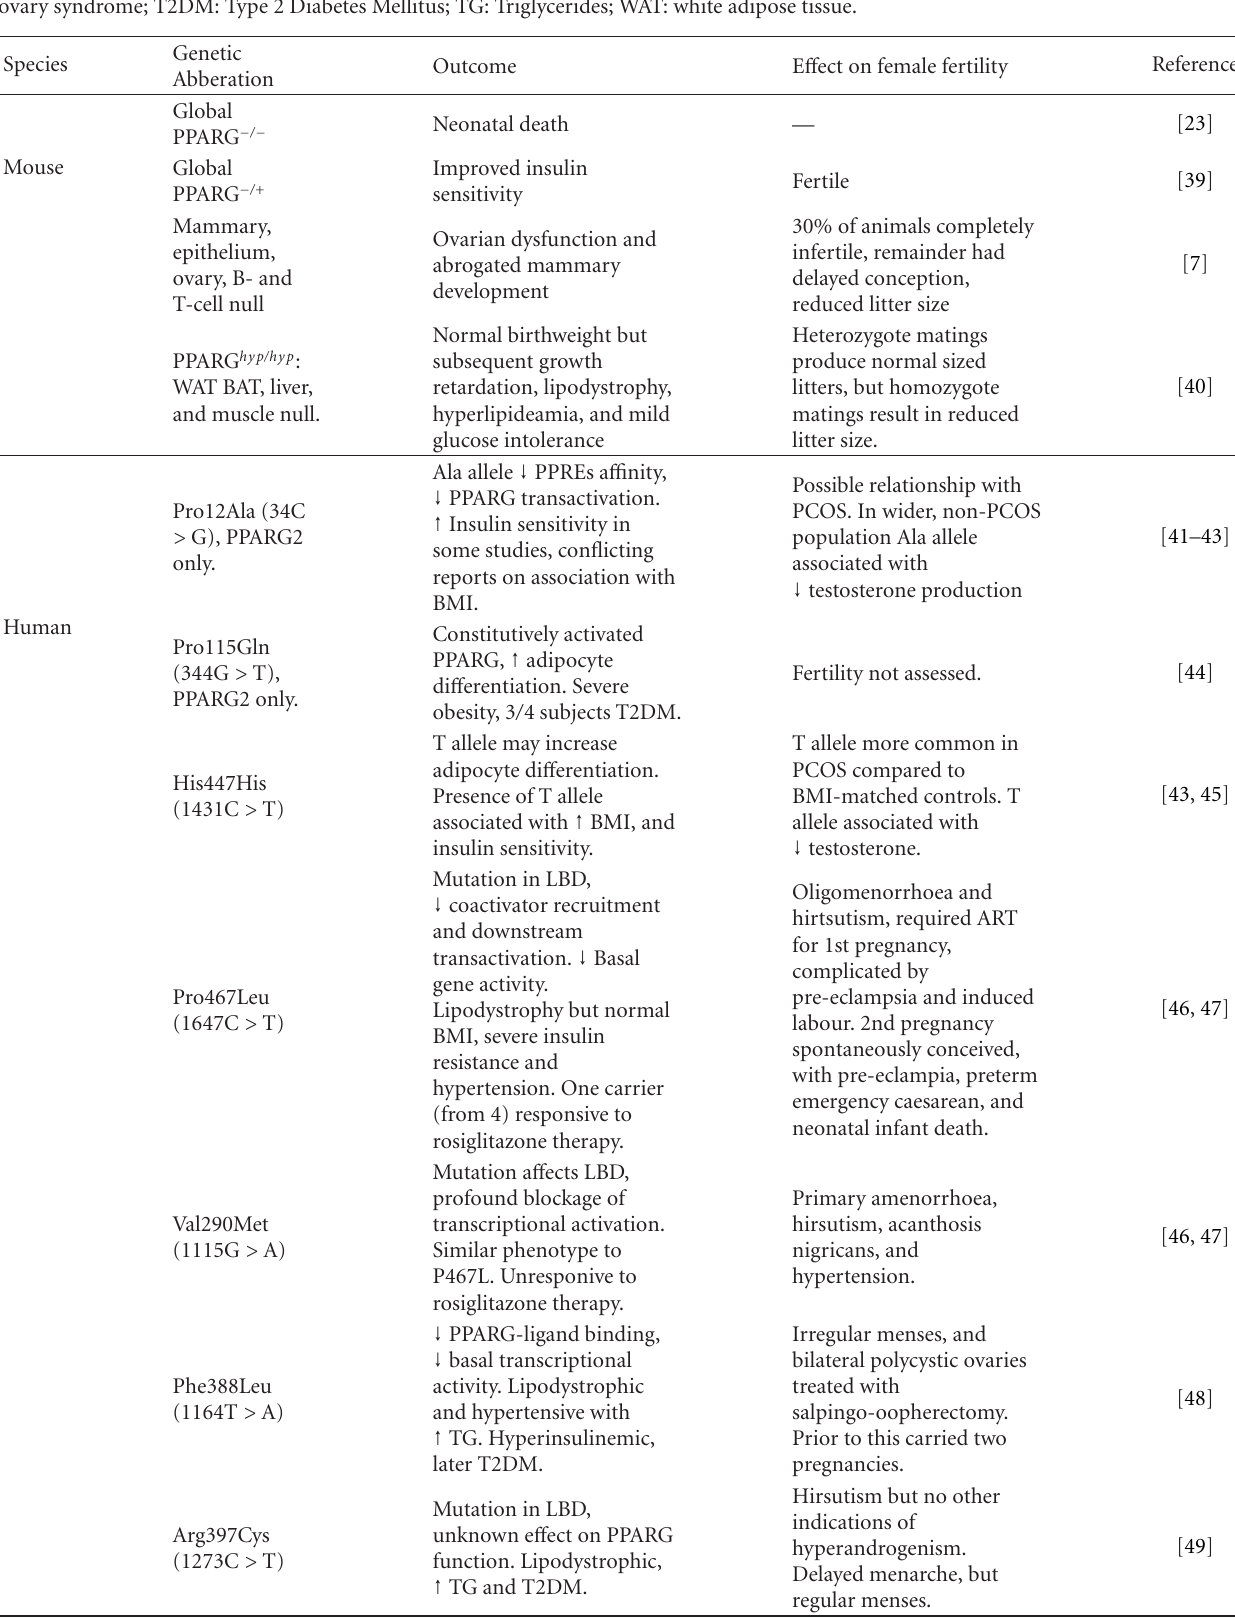
Table 1: Phenotypes and reproductive e ff ects associated with PPARG mutations in mice and humans . Abbreviations used: ART: artificial re- productive technology; BAT: brown adipose tissue; BMI: body mass index; HbA(1C): haemoglobin A1C; KO: knock-out; PCOS: polycystic ovary syndrome; T2DM: Type 2 Diabetes Mellitus; TG: Triglycerides; WAT: white adipose tissue. Outcome E ff ect on female